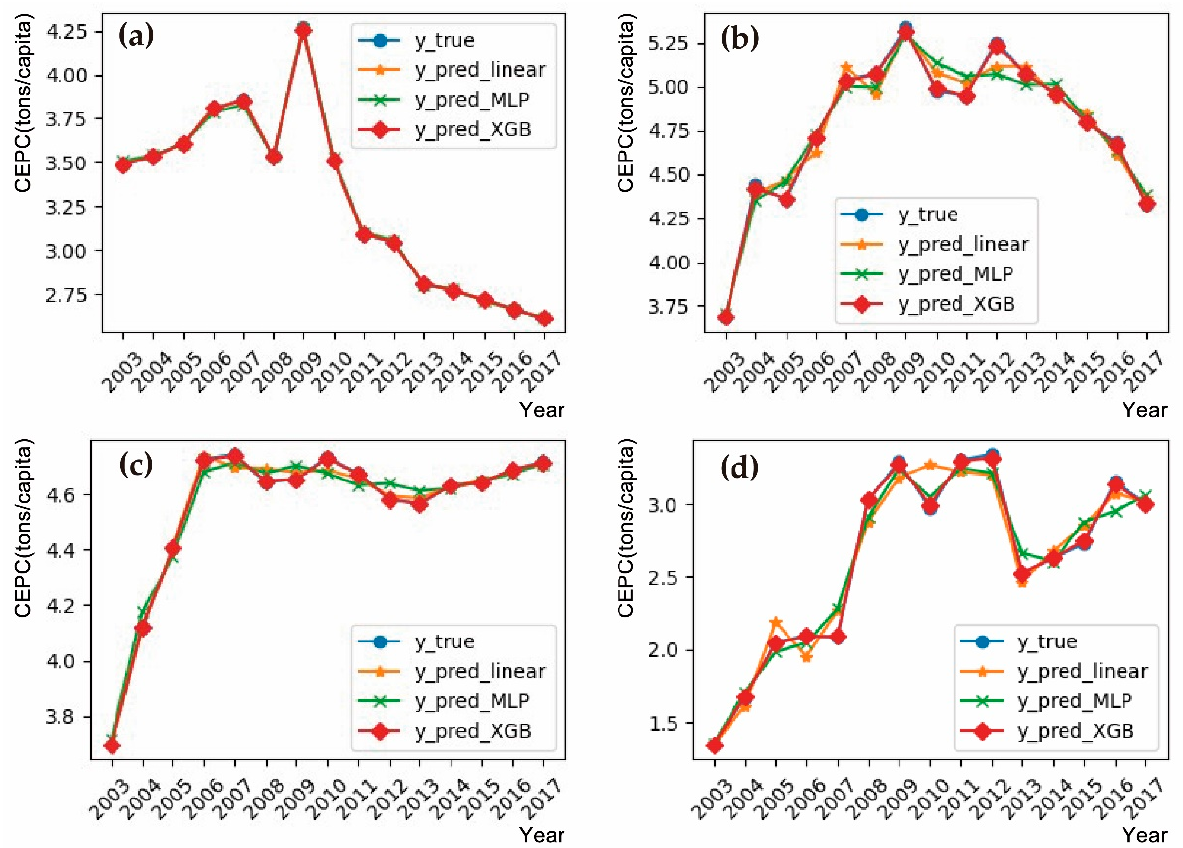
Figure 3. CEPC and influence factors regression results using XGBoost. ( a ) Beijing; ( b ) Tianjin; ( c ) Shanghai; ( d ) Chongqing.